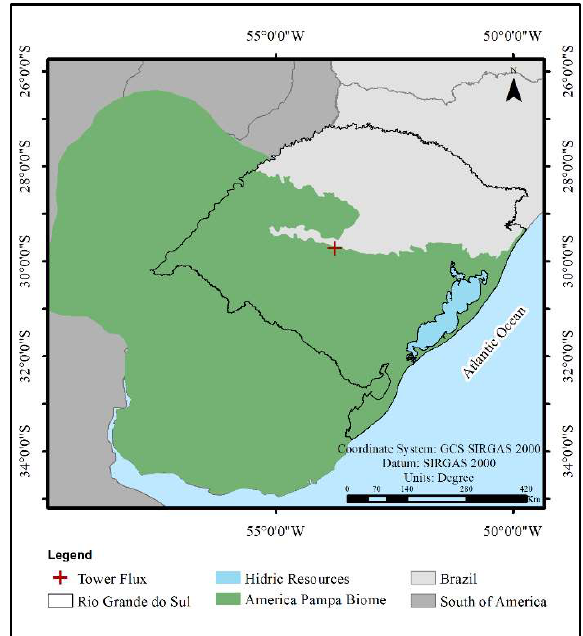
Figure 1. American Pampa Biome and Tower Flux location